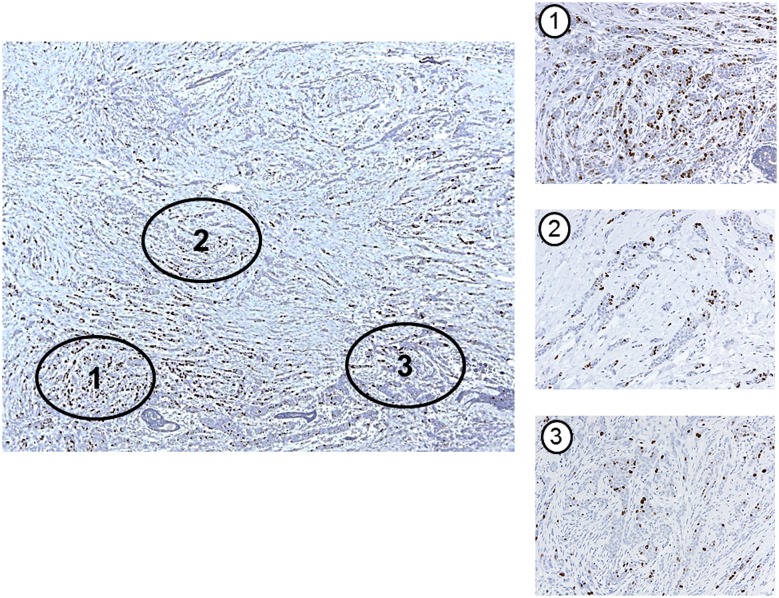
An example of counting area selection in a tumor with heterogeneous Ki-67 expression.Three representative areas have been selected including a hot spot (area 1). (Original magnification: x 40 (large photo); x 200 (three small photos)).